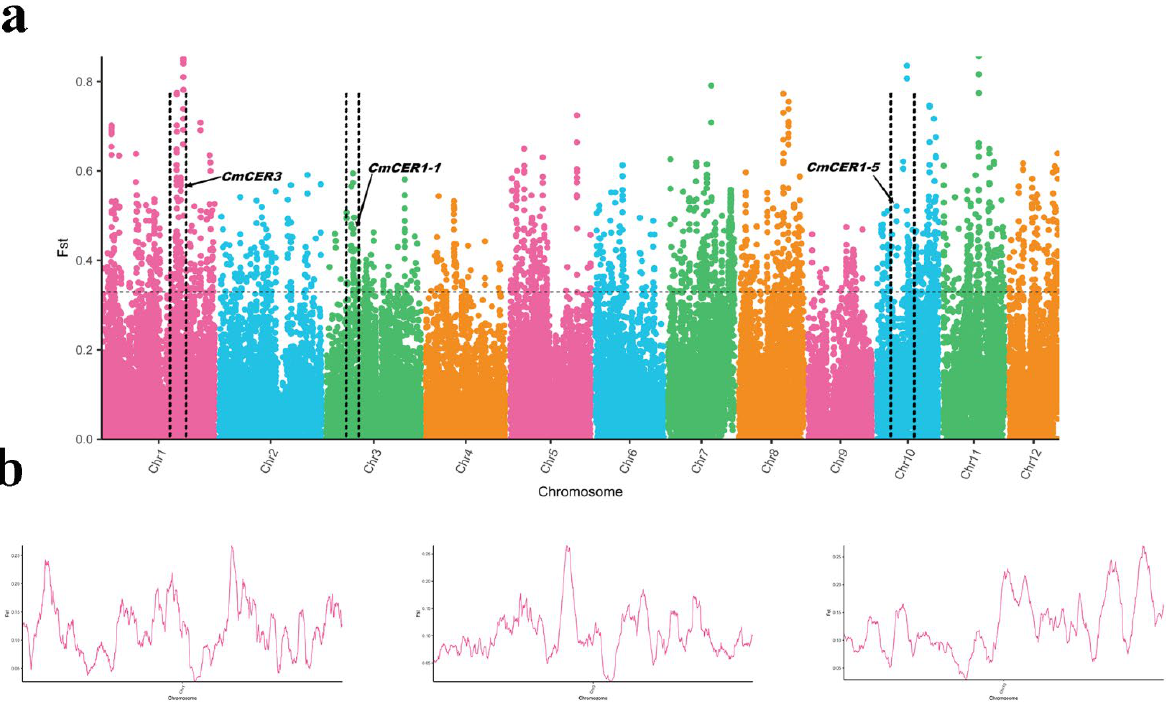
Figure 2. ( a ) Genomic landscape of the population differentiation in groups I (Gansu) and II (Tianmu Mountains) of wild Chinese chestnut, as measured by the fixation index (FST). ( b ) Sliding analysis for further window analysis for further presentation.